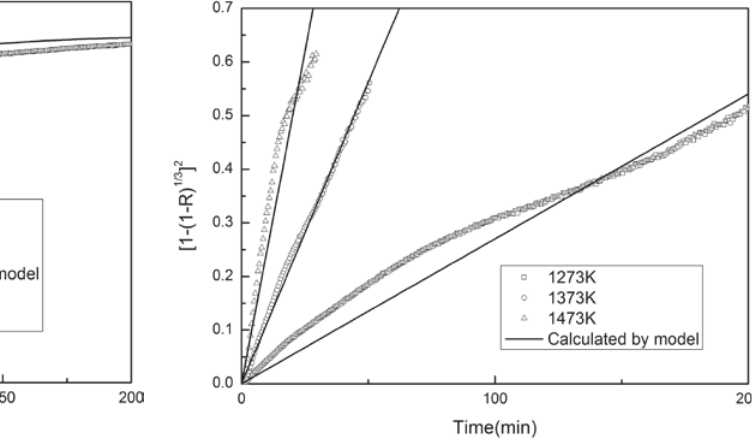
Fig. 5: A comparison between experimental data and theoretical predictions from the RPP model at different temperatures